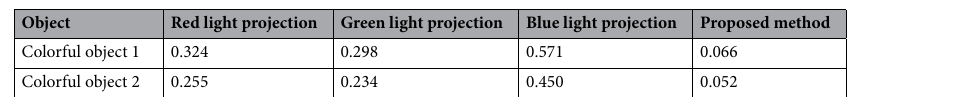
Figure 11. 3-D shape reconstruction of a colorful object. ( a ) Another colorful object. ( b ) A captured image without fringe projection. ( c ) Original projection fringe pattern. ( d ) Optimized projection fringe pattern. ( e ) A captured fringe pattern during red light projection. ( f ) A captured fringe pattern during green light projection. ( g ) A captured fringe pattern during blue light projection. ( h ) Optimized captured fringe pattern using the method proposed in this paper. ( i ) Reconstructed 3-D surface shape during red light projection. ( j ) Reconstructed 3-D surface shape during green light projection. ( k ) Reconstructed 3-D surface shape during blue light projection. ( l ) Reconstructed 3-D surface shape using the method proposed in this paper.